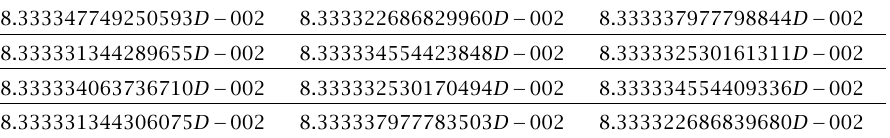
Table 3.14 . The charge distribution with n = 12 , l = 0 . 25 on γ 0 .